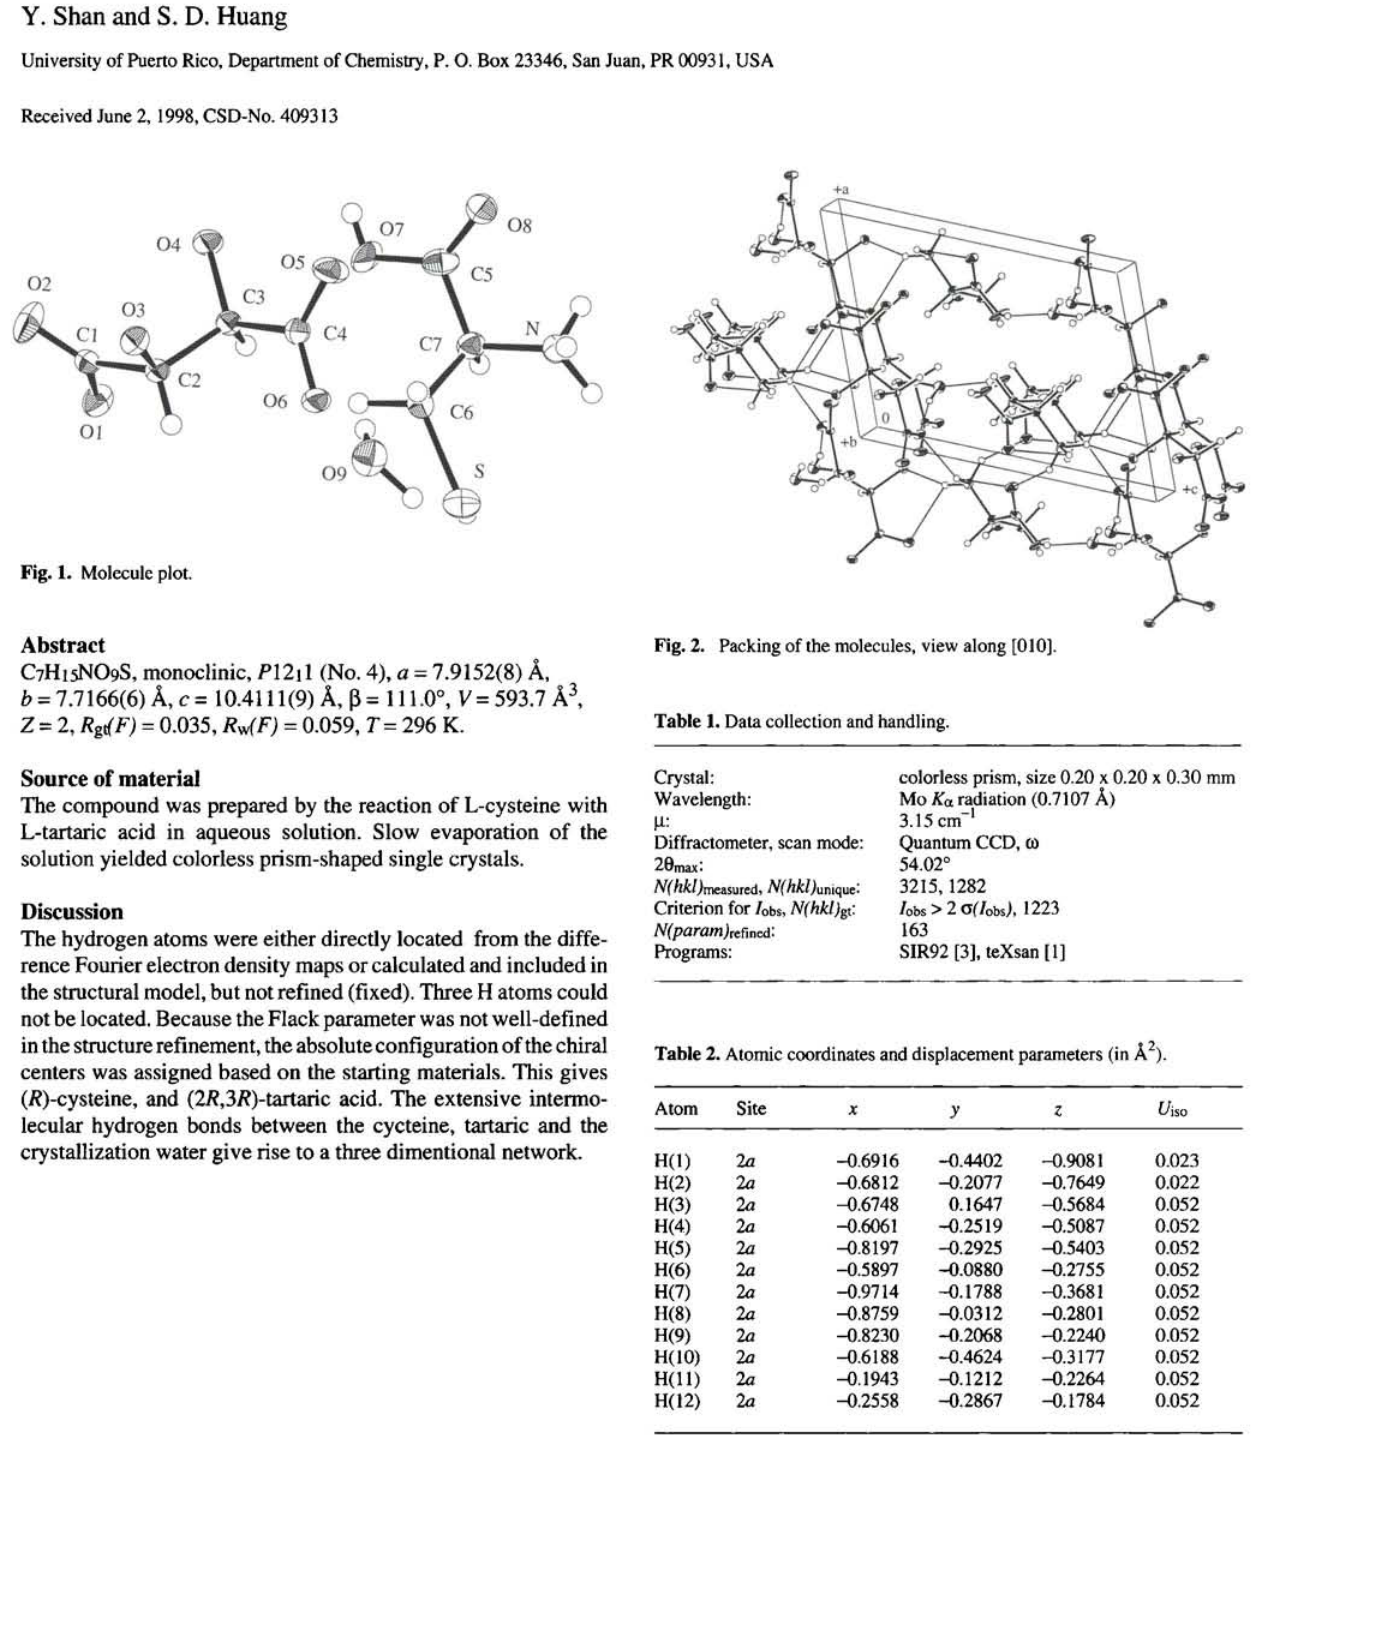
Table 2. Atomic coordinates and displacement parameters (in Â 2